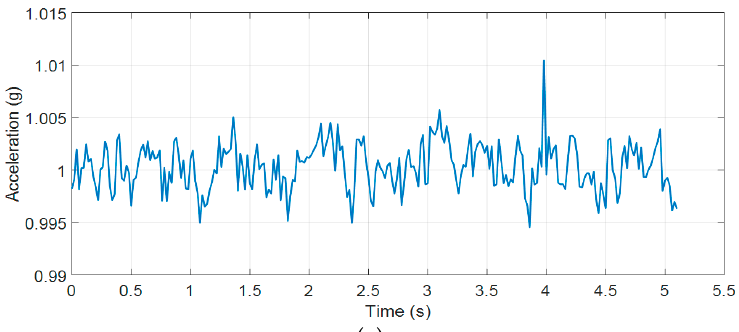
Figure 12. The loss of physical performance because of the accident (crawling then falling); ( a ) the RMS of accelerometer data; ( b ) the barometric data.